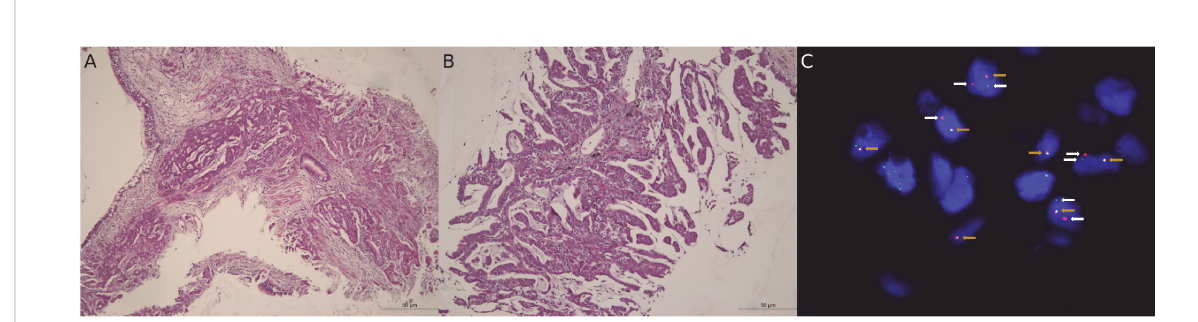
FIGURE 1 Pathological and molecular analysis of tumor samples. (A, B) . Hematoxylin and eosin (HE) staining shows neoplastic cells with morphological characteristics of lung adenocarcinoma. (A) Picture magni fi cation: 5x; scale bar: 50 µm. (B) Picture magni fi cation: 10x; scale bar: 50 µm. (C) Fluorescent in situ hybridization (FISH) reveals an ALK rearrangement (IQFISH break apart DAKO (Omnis)). ALK break-apart FISH utilizes DNA probes that hybridize to the 3 ’ (red signal) and 5 ’ (green signal) regions of the common fusion breakpoint in ALK gene. ALK rearrangement is identi fi ed by splitting of the red and green signals in the nuclei (white arrows) or isolated red signals, as opposed to fused adjacent red and green signals (yellow arrows). Picture magni fi cation: 1000x